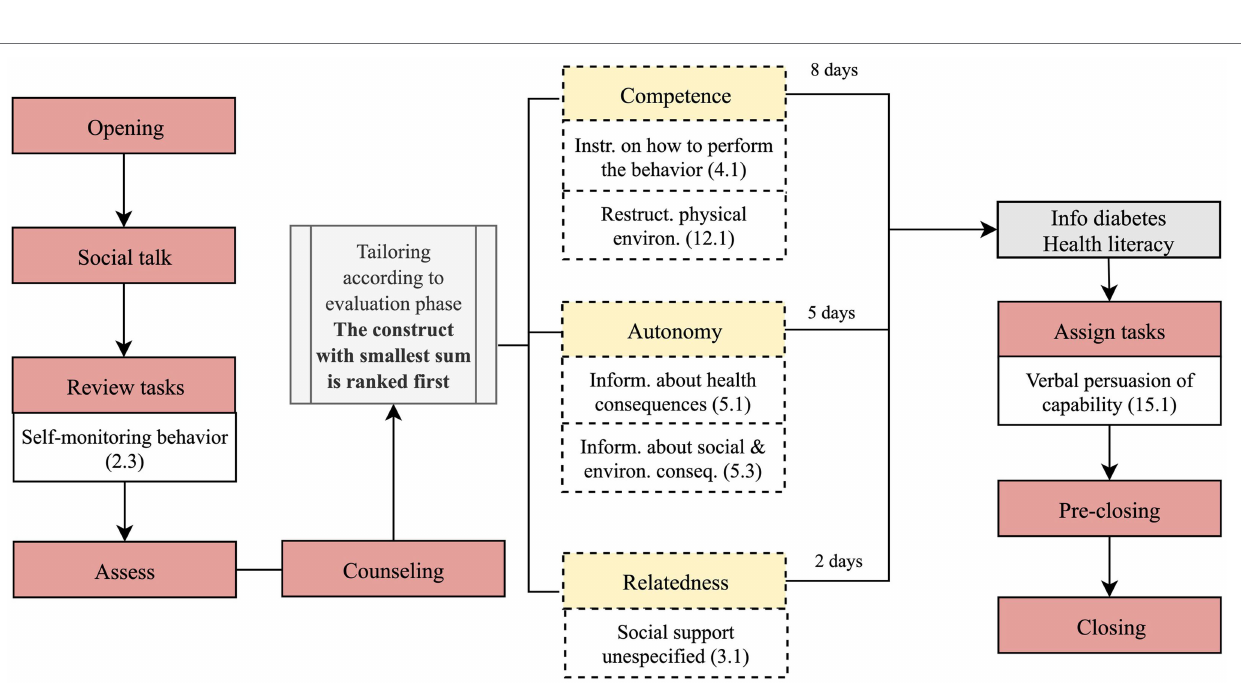
FIGURE 4 | Dialogue flow on day 2 and even days of physical activity component of the follow-up